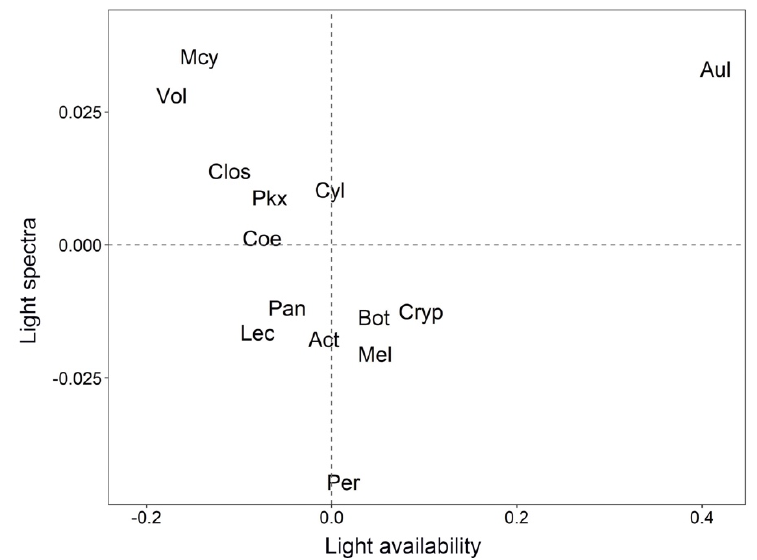
Figure 5. Principal Phytoplankton genera plotted in a Intrastructure graph. The light availability axis is related to K d , with low light (high K d ) on the left and high values (low K d ) on the right. The light spectrum axis is related to the different wavelengths (400 to 700 nm).